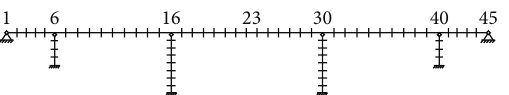
Figure 11: Finite element model of bridge.